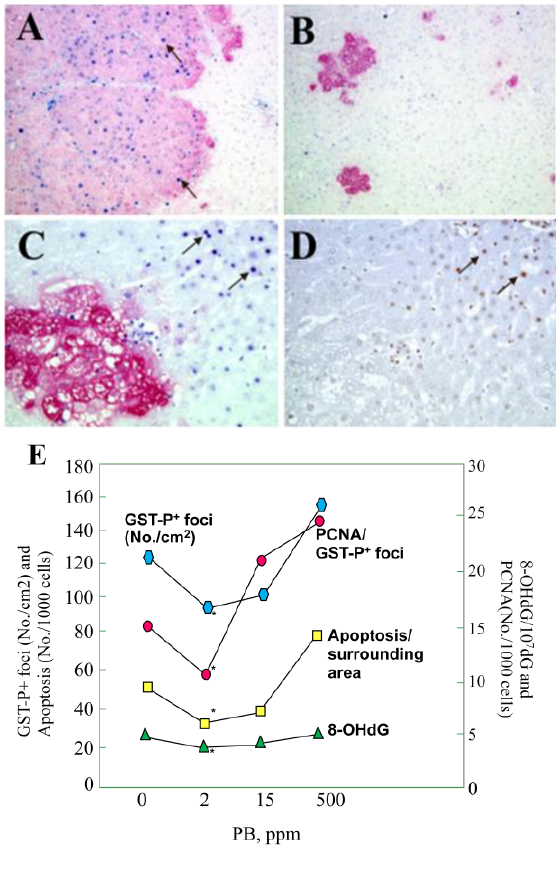
Figure 2. Double immunohistochemistry for GST-P (red) and PCNA (blue), GST-P (red) and apoptosis (ssDNA) (blue) and immunohistochemical assessment of 8-OHdG (black/brown) in the livers of F344 rats treated with PB for 10 weeks after DEN initiation. ( A and B ) GST-P and PCNA after PB at 500 ppm (×100); and 2 ppm (×100), respectively; ( C ) GST-P and apoptosis after PB at 500 ppm (×200); ( D ) 8-OHdG immunohistochemistry in the liver of the rat treated with PB at 500 ppm (×200). Note, that C and D are serial liver sections and the good concordance between 8-OHdG and ssDNA stainings; ( E ) Co-ordinated change in GST-P positive foci numbers and PCNA indices, for apoptosis and 8-OHdG levels in background liver parenchyma after DEN then PB for 10 weeks. Note the inhibitory effects of PB at the dose of 2 ppm and elevation at 500